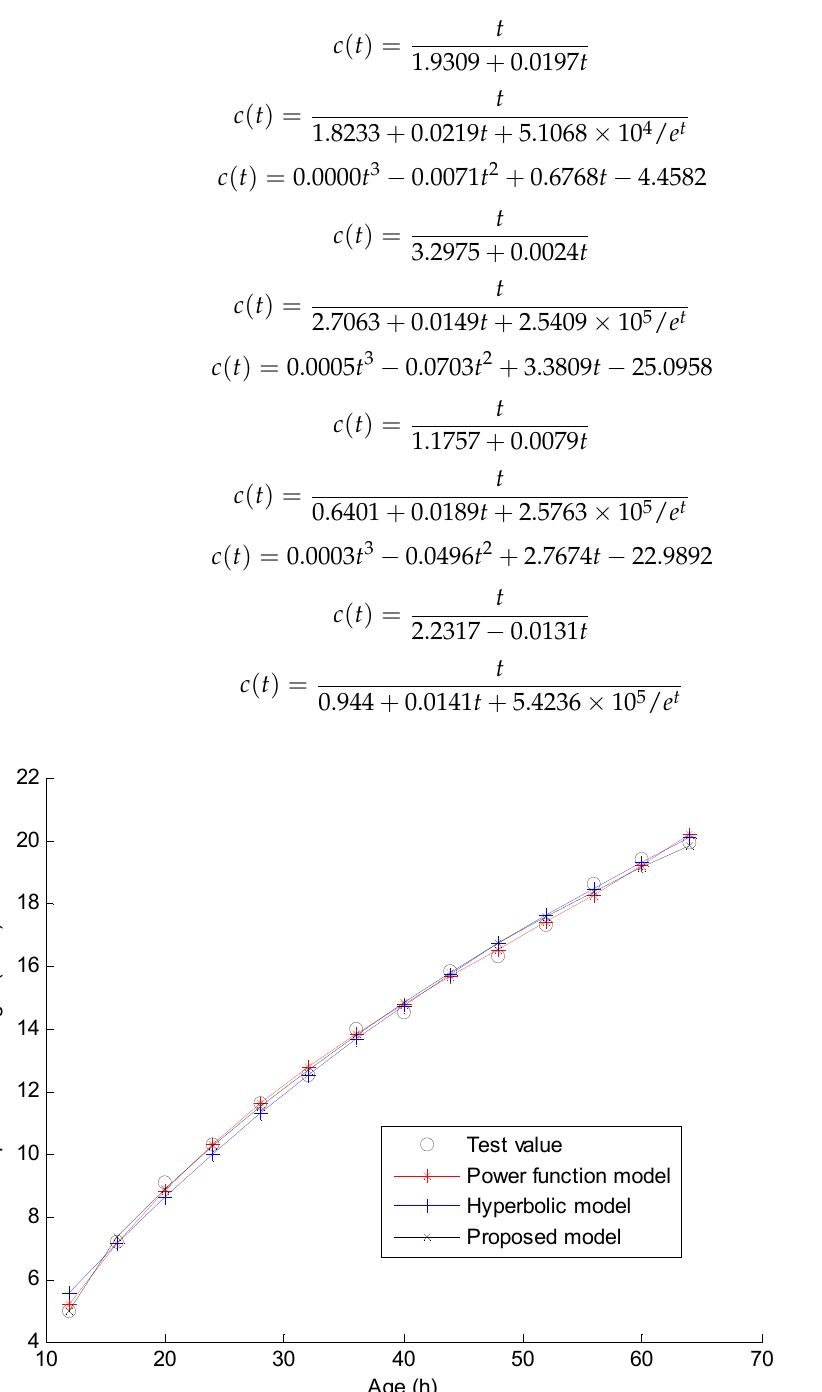
Figure 1. Curve fitting results using the three models for C30 under natural curing.